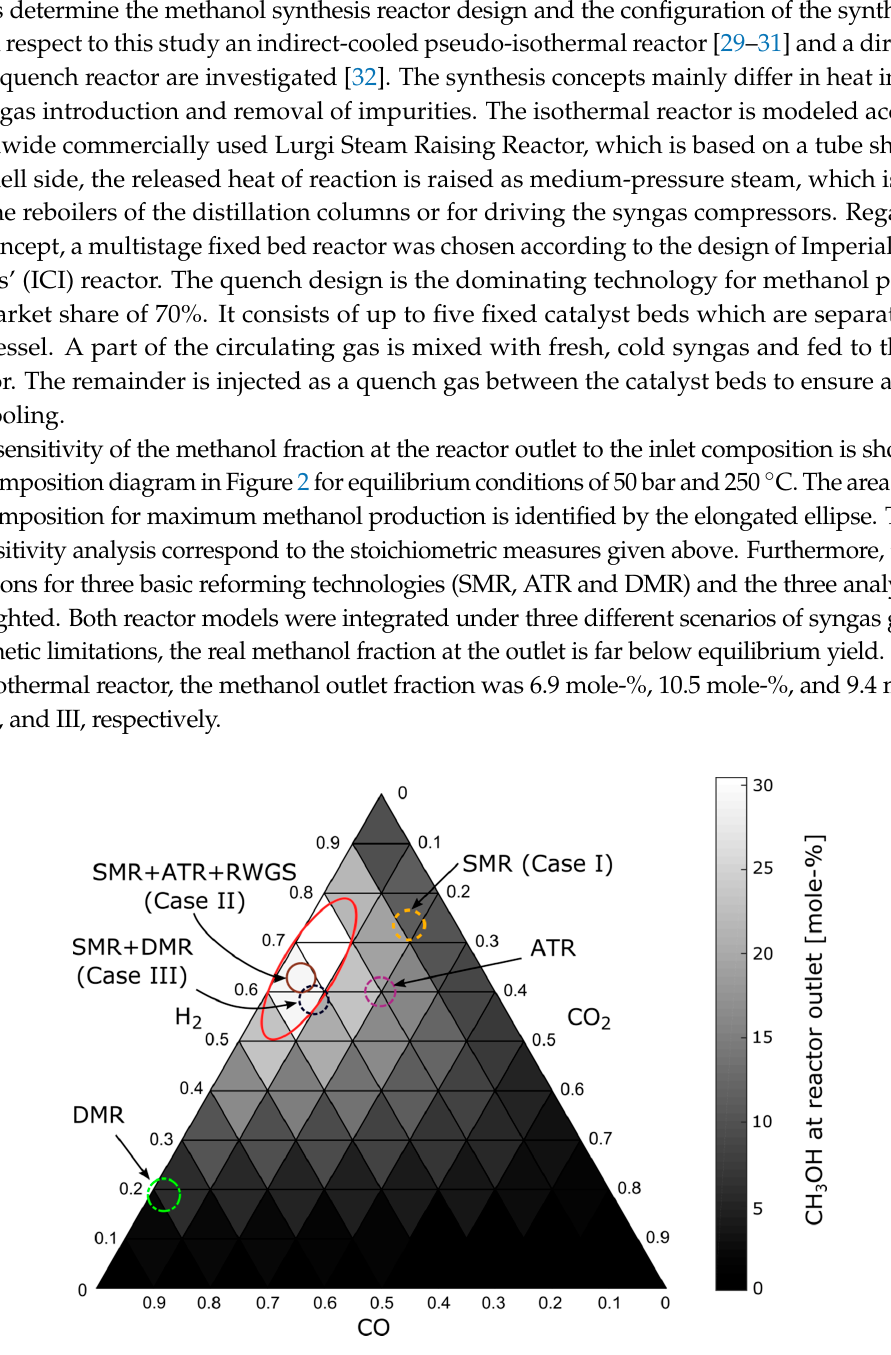
Figure 2. Ternary diagram for the methanol yield at an equilibrium pressure of 50 bar and an equilibrium temperature of 250 ◦ C for a given inlet composition. The syngas composition for the basic reforming technologies SMR, ATR and DMR and the investigated cases are